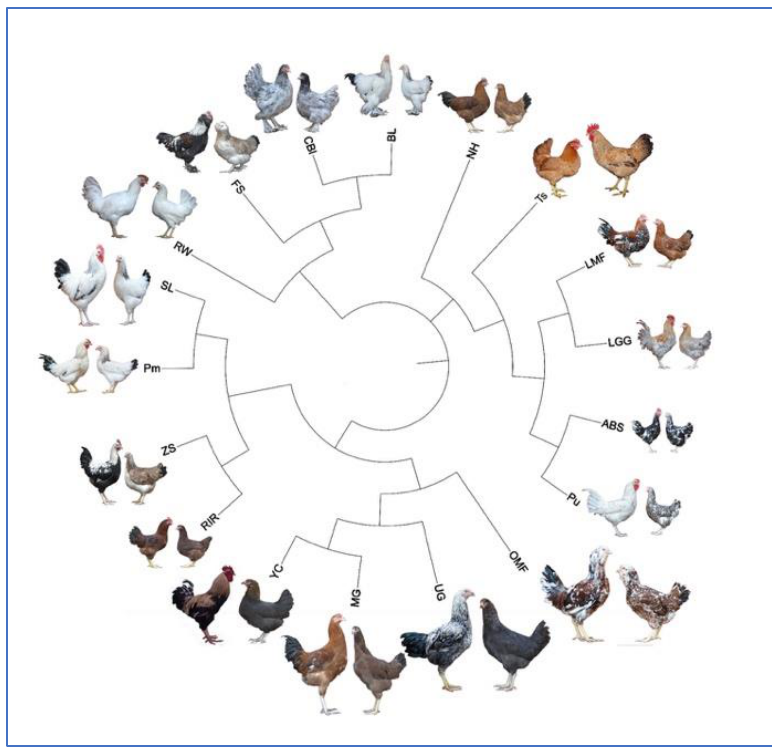
Figure 2. Phylogenetic tree for 18 chicken breeds plotted using pairwise DNA fingerprinting-derived genetic distances (Supplementary Table S2). The corresponding Newick tree format is shown in Supplementary Information S2.